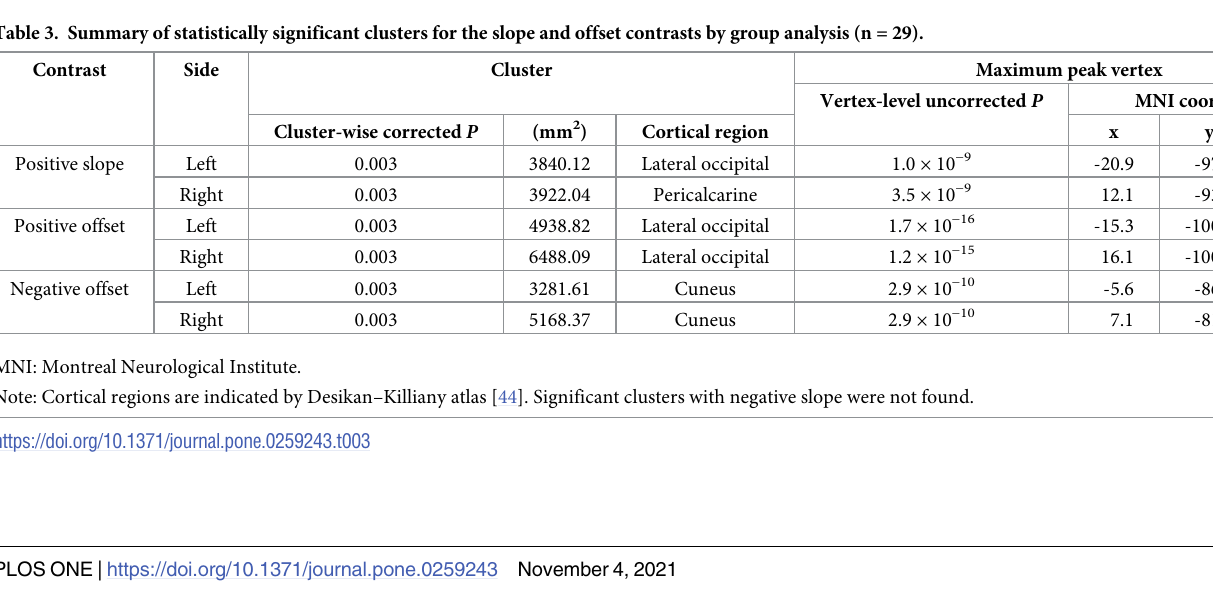
Table 3. Summary of statistically significant clusters for the slope and offset contrasts by group analysis (n = 29). Contrast Side Cluster Maximum peak vertex Cluster-wise corrected P Positive slope Left 0.003 Right Positive offset Left Right 0.003 Negative offset